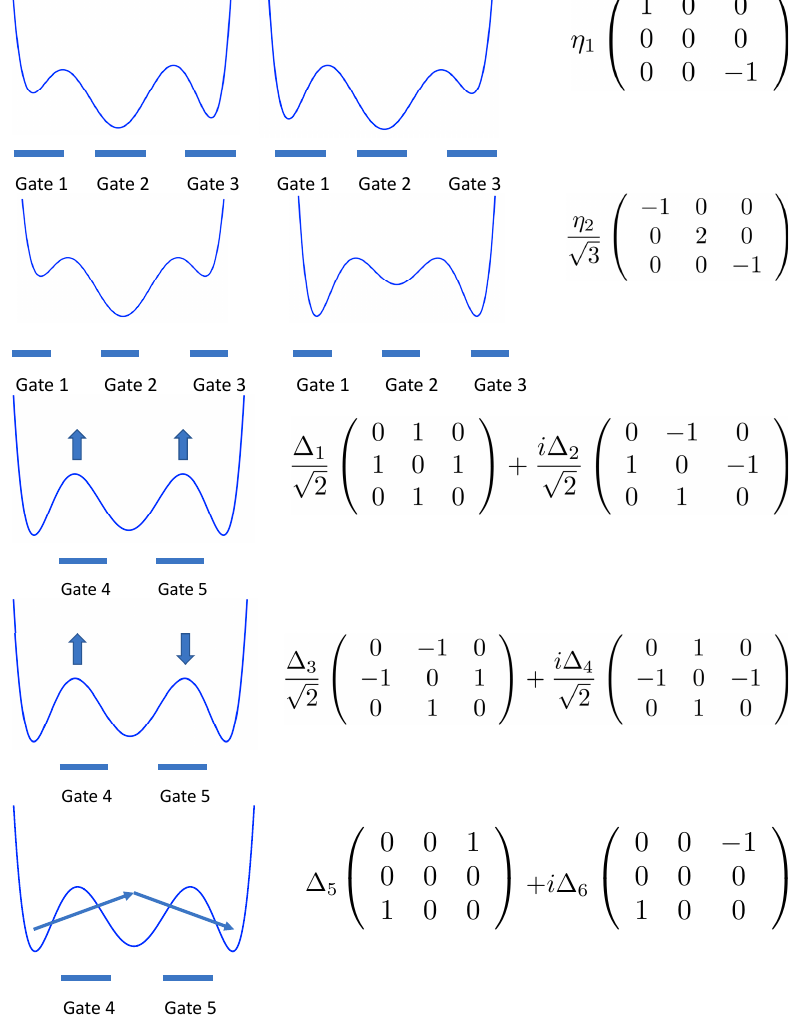
Figure 5: Slow noise produced by the back gate in the serial triple QD. First and second rows: fluctuations of the level positions in each of three QD. Third row: sym- metric fluctuations of the barriers. Fourth row: anti-symmetric fluctuations of the barriers. Bottom row: fluctuations of the co-tunneling. The same processes will nat- urally appear in the triangular QD Fig. 2d and describe direct tunneling between the first and the third dot. Eight 3 × 3 Gell-Mann matrices constitute the basis for the fundamental representation of the SU ( 3 )